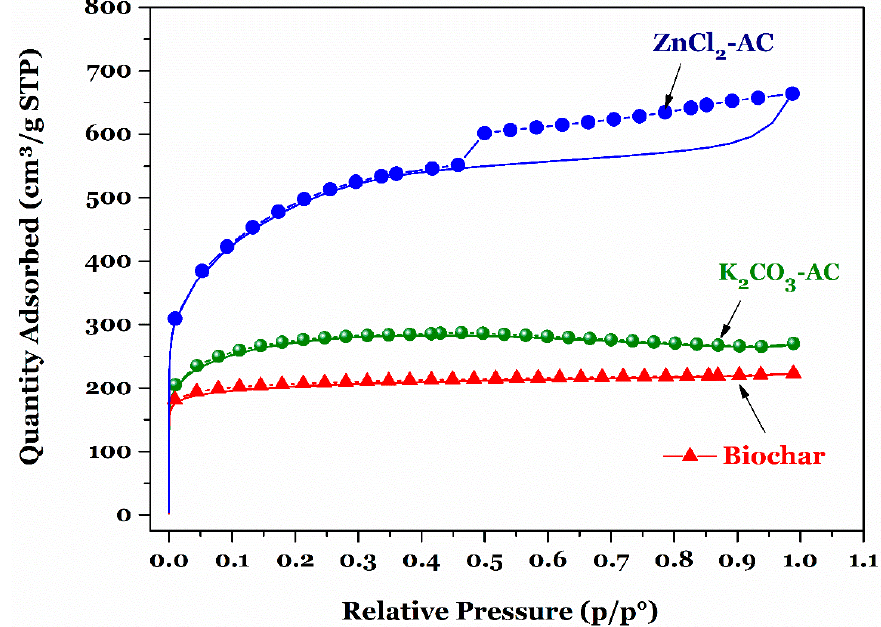
Figure 1. Nitrogen adsorption / desorption isotherm of the biochar and activated carbon (AC) samples. Table 1 summaries some corresponding textural properties of three prepared samples. As